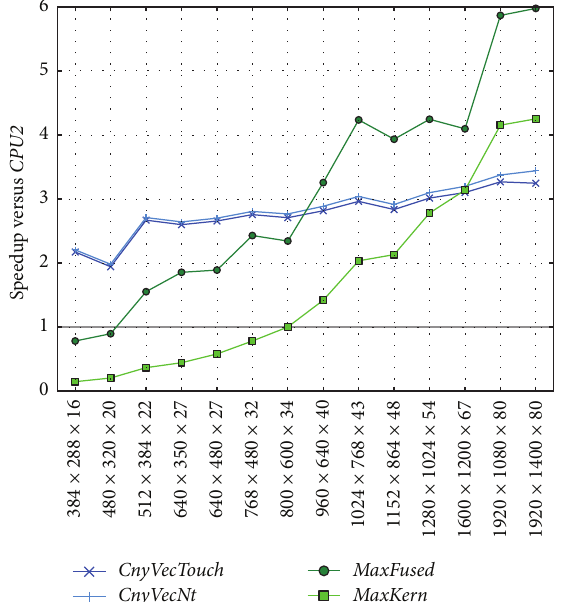
Figure 14: Low-disparity image series. Speedups of accelerated configurations compared to slower CPU2 . Max versions have an additional advantage because their host parts run on the faster CPU1.